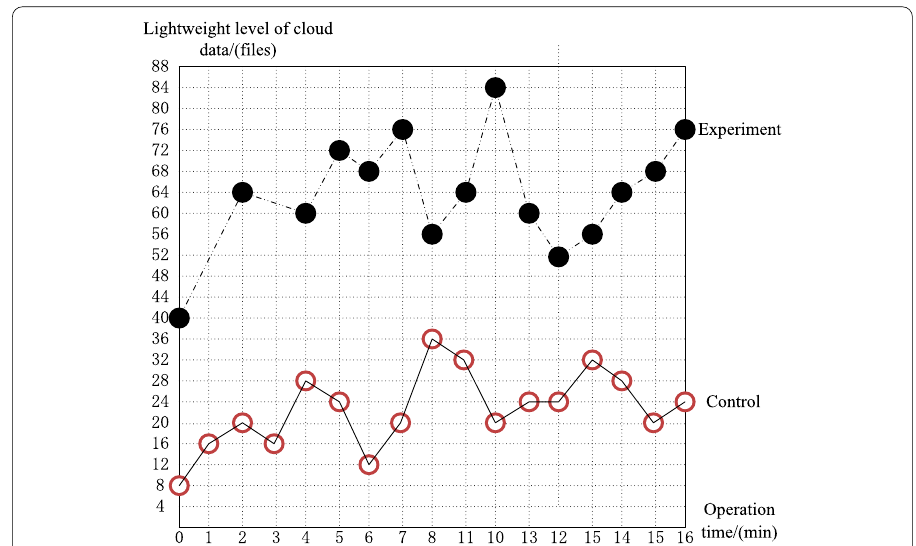
Fig. 5 Comparison of lightweight level of cloud data (operation status of low mechanical parameter)